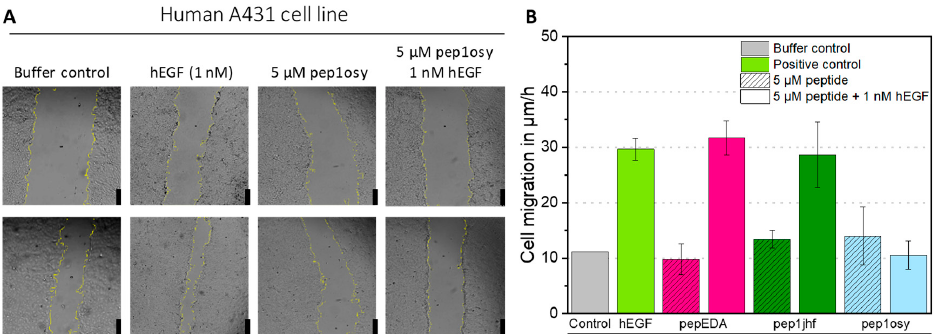
Figure 3. E ff ect of EGFR-directed peptides in the presence of the natural EGFR-ligand EGF in a wound healing assay with A431 cells. ( A ) A431 cells were incubated with a premixed solution of 1 nM hEGF and 5 µ m peptide (here as example pep1osy) or with a 5 µ m peptide solution only, and bright field images were taken with an automated inverted microscope (Leica) over 6 h. Here, images after 0 h (upper row) and 6 h (bottom row) are given as examples. The yellow cell borders were detected by image recognition using ImageJ. Scale bars given as black bars represent 250 µ m. ( B ) Bar chart presenting the cell migration velocity as determined from microscopy images. Calculations are based on linear regressions shown in Figure S6. The migration is given for each peptide (shaded color) and each peptide mixed with 1 nM hEGF (uniform color) Experiments were performed in biological duplicates and data is represented as mean ±